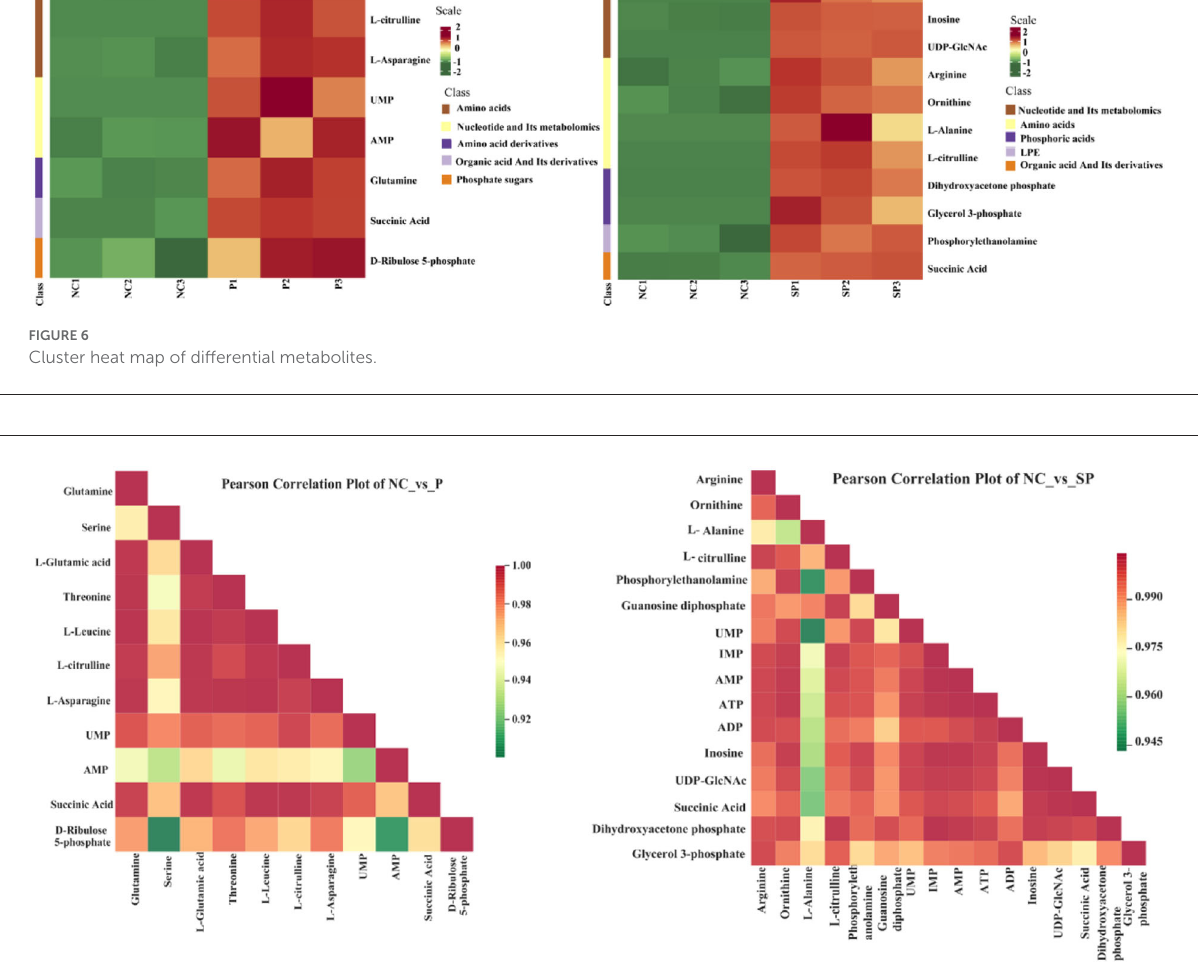
FIGURE7 Correlation analysis diagram of differential